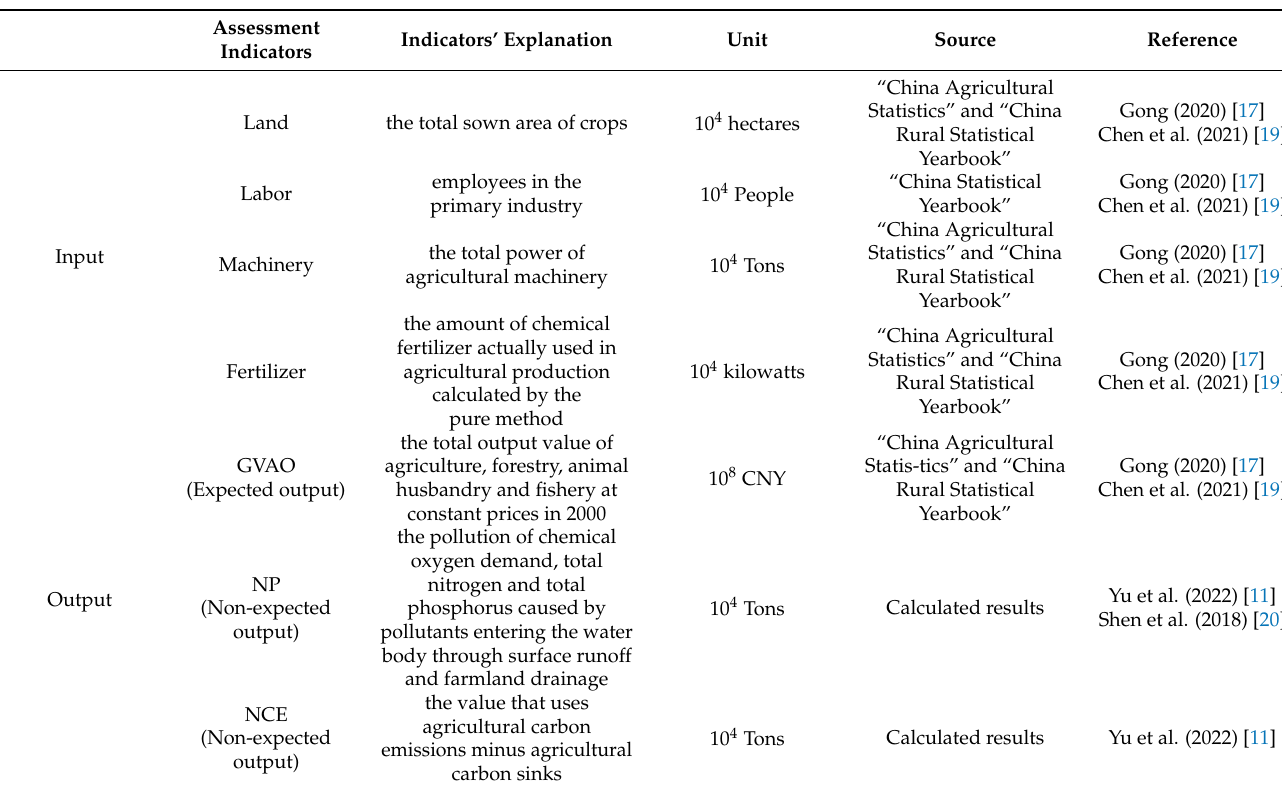
Table 1. AGTFP assessment indicators and data